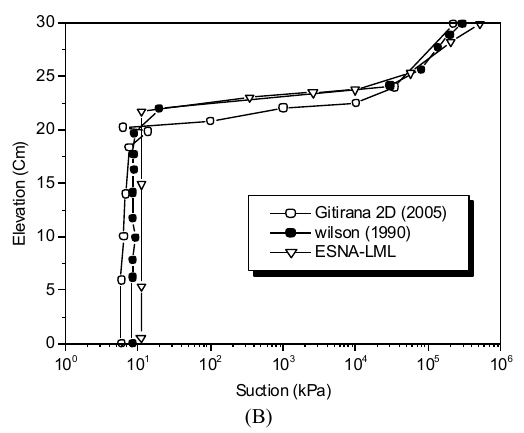
Figure 3b. Verfication of the numerical model on the test of Wilson (1990) - Suction variton Fig. 3b. Verfication of the numerical model on the test of Wil- son (1990) – Suction